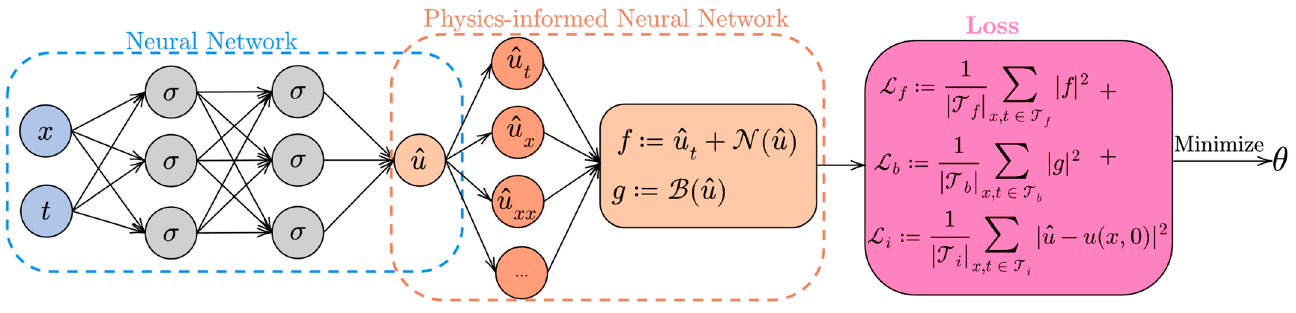
Figure 2. Physics-informed neural network building process.